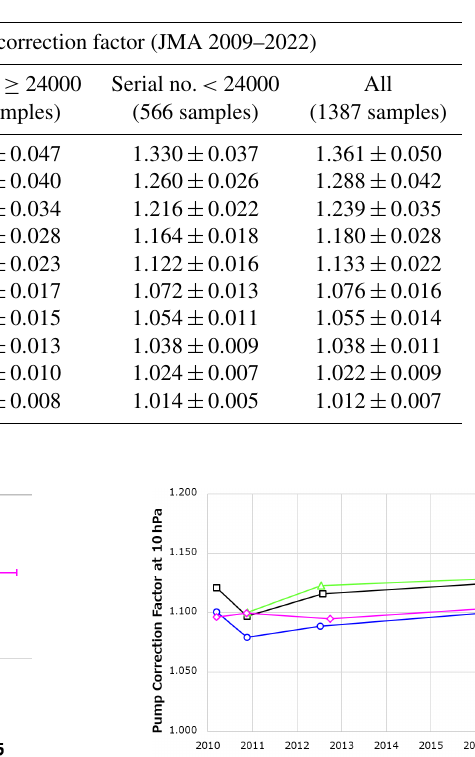
Table 2. Average JMA pump correction factors for pre- and post-24000 sensor serial numbers and for the entire time period (2009 to 2022).